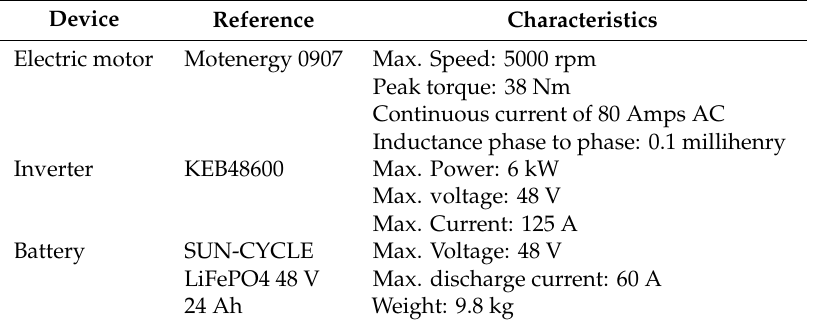
Table 4. Technical data of the electric system.